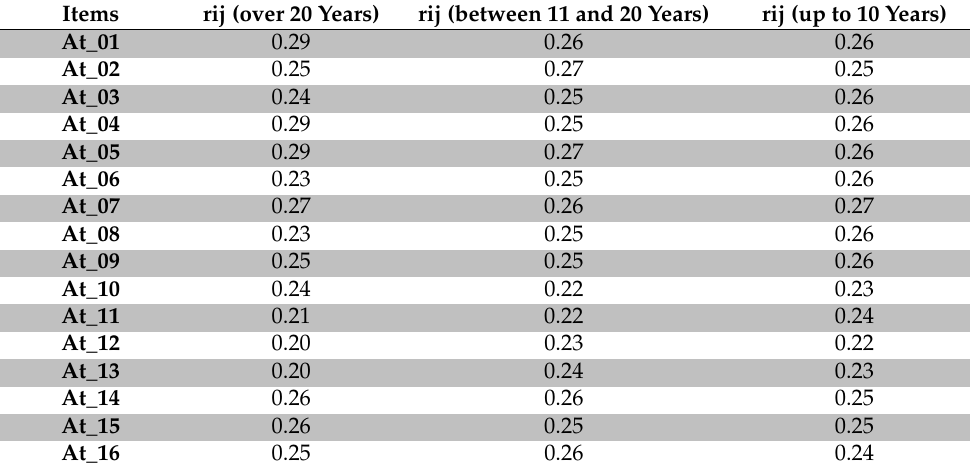
Table 6. Matrix R with normalized values.